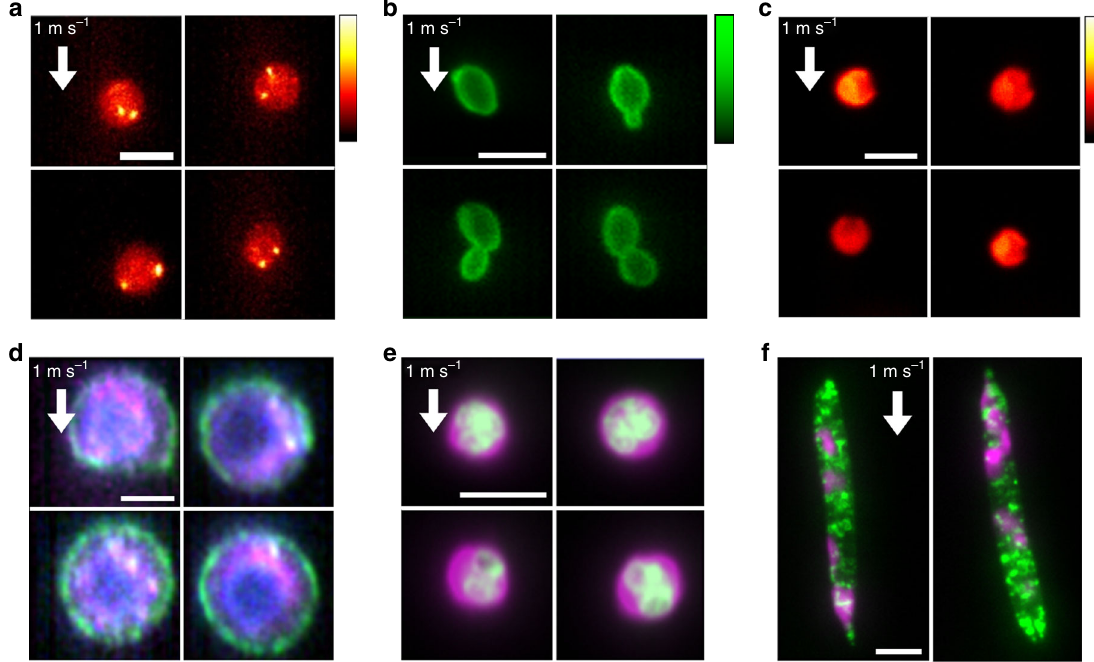
Fig. 3 Fluorescence images of diverse cell types obtained by VIFFI fl ow cytometry. All the images were obtained at a fl ow speed of 1 m s − 1 . a FISH images of Jurkat cells. Two bright spots (shown in yellow-white) corresponding to two copies of chromosome 8 are evident in each cell. b Fluorescence images of S. cerevisiae whose cell wall was stained by FITC-concanavalin A, showing budding daughter cells from their mother cells. c Auto fl uorescence images of C. reinhardtii cells, showing their characteristic morphological features (indented elliptical shape at the head). d Three-color fl uorescence images of human lung adenocarcinoma cells (PC-9). Magenta: protoporphyrin IX induced by 5-aminolevulinic acid; Green: EpCAM stained by VU-1D9; Blue: nucleus stained by Hoechst 33342. e Two-color fl uorescence images of murine neutrophils. Green: nucleus stained by SYTO16; Magenta: cytoplasm stained by CellTracker Red. f Two-color fl uorescence images of E. gracilis cells. Green: lipids stained by BODIPY505/515; Magenta: auto fl uorescence of chlorophyll. Scale bars: 10 µ